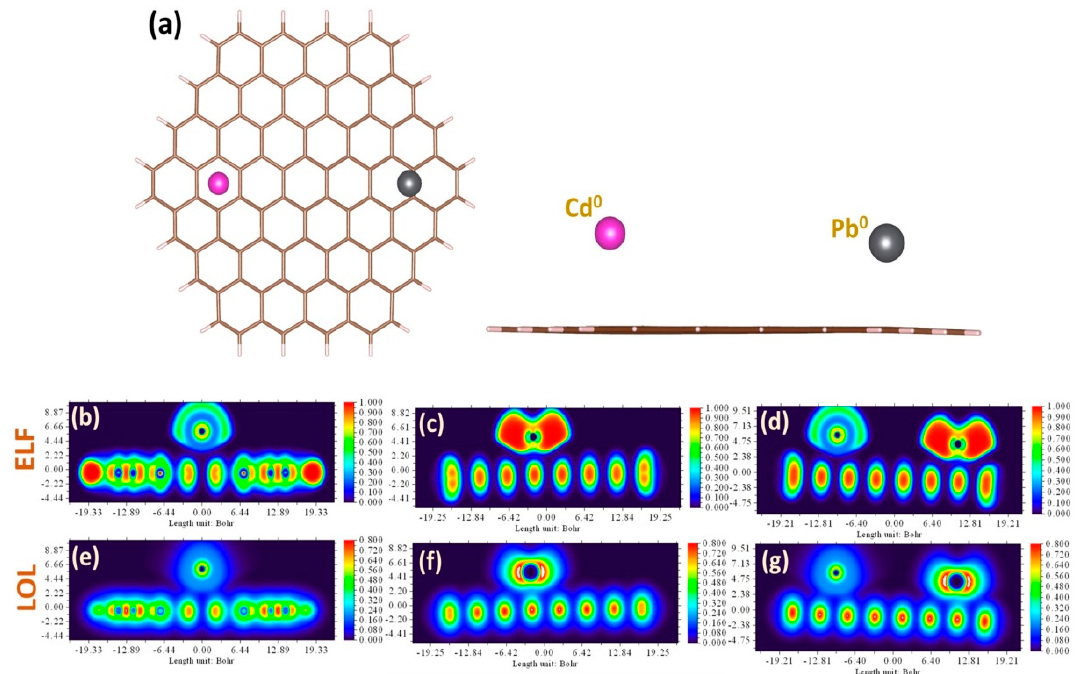
Figure 6. ( a ) Top view and side view of the simultaneous presence of Cd 0 and Pb 0 neutral metal adatoms on the graphene surface. Contour plots of the electron localization function (ELF) and color-filled maps of localized orbital locator (LOL) for the elemental heavy metal species adsorbed onto graphene: Cd 0 on Gr ( b , e ), Pb 0 on Gr ( c , f ), and Cd 0 and Pb 0 on Gr ( d , g ), respectively.